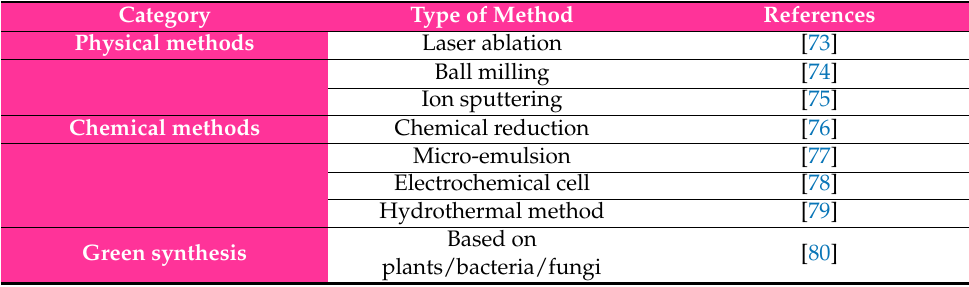
Table 1. Main synthesis methods for silver nanoparticles. Category Type of